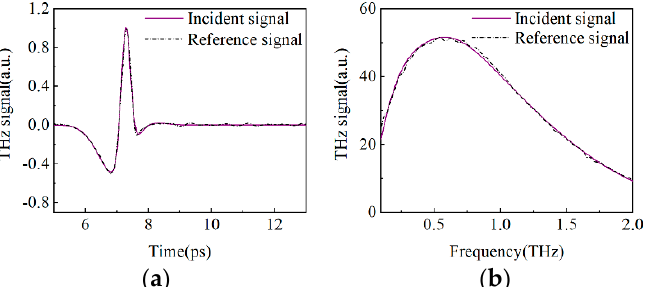
Figure 7. The incident signal compared with the reference signal: ( a ) Time-domain; ( b ) Frequency- domain.